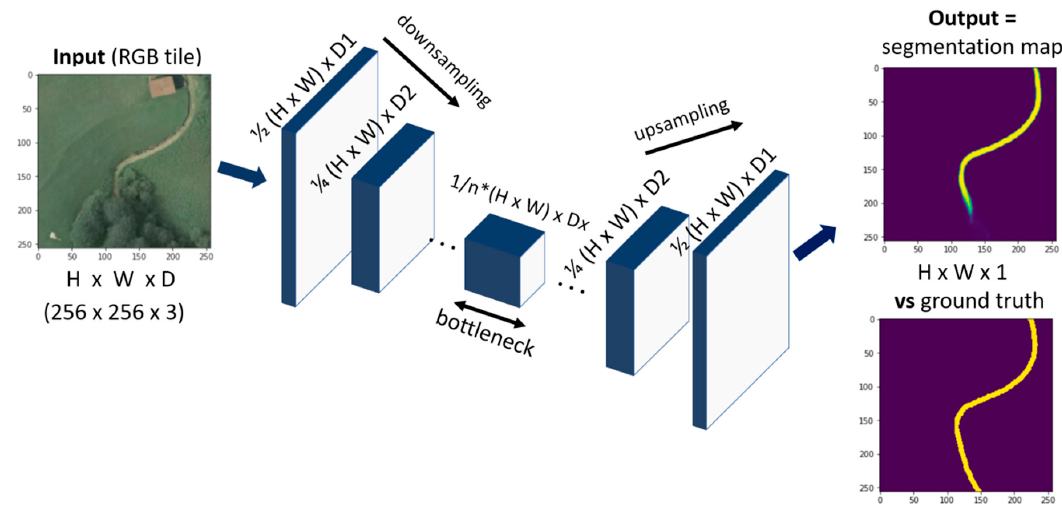
Figure 2. Example of processing a random tile through the encoder–decoder structure.